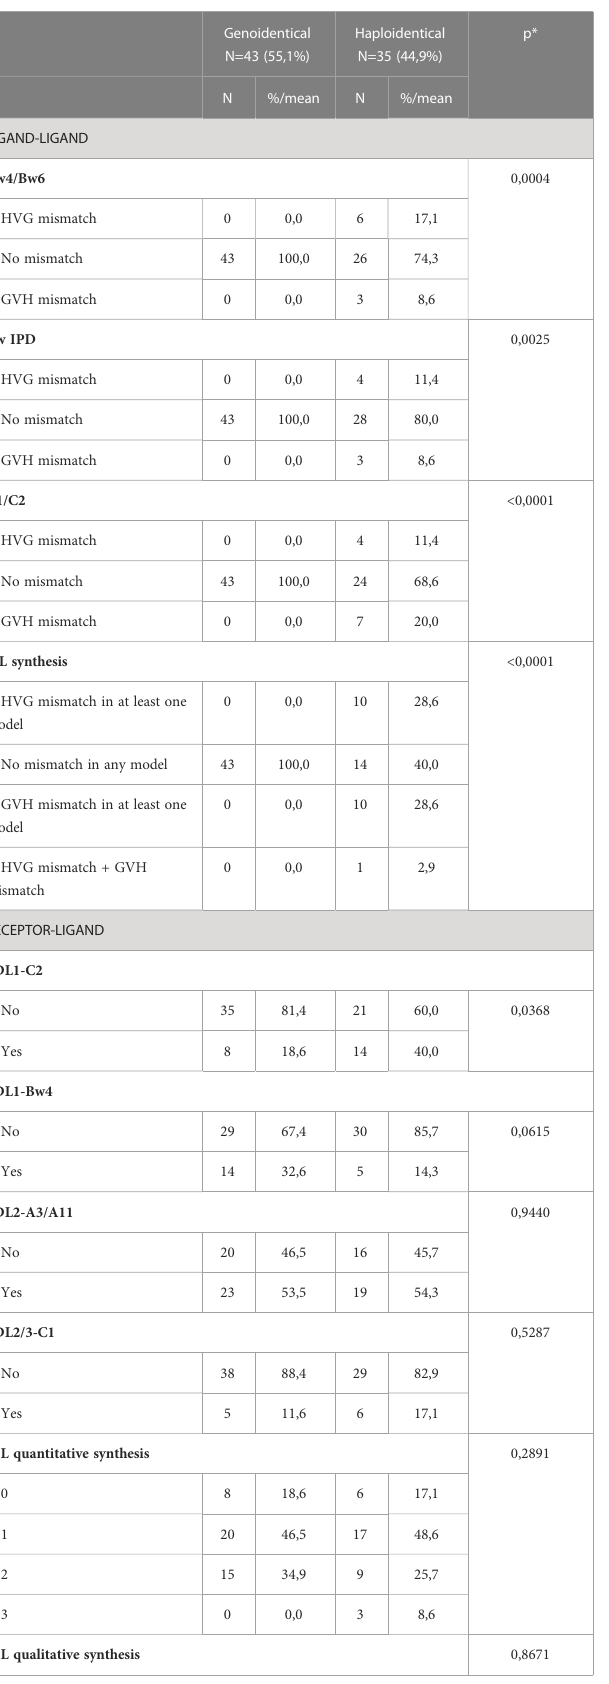
Genoidentical Haploidentical N=43 (55,1%) N=35